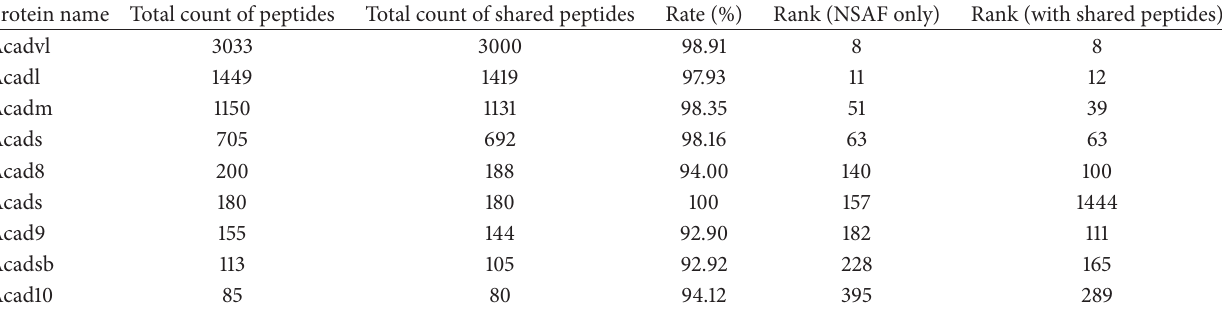
Table 1: The analysis of proteins in acyl-CoA dehydrogenase